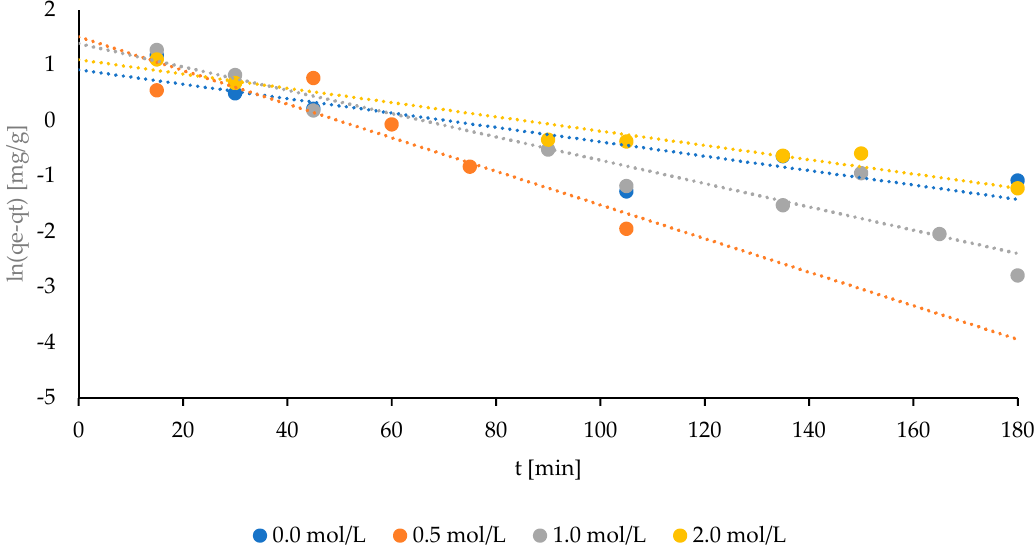
Figure 5. The adaptation of experimental data of ammonium adsorption obtained for the natural and modified Bentonite I–Freundlich isotherms.